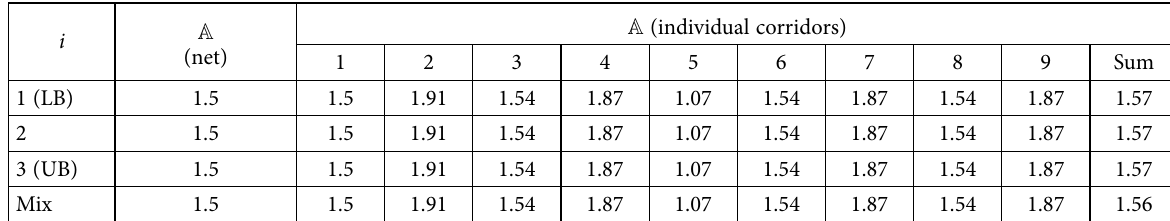
Table 6. Ratio of Table 2 to Table 3